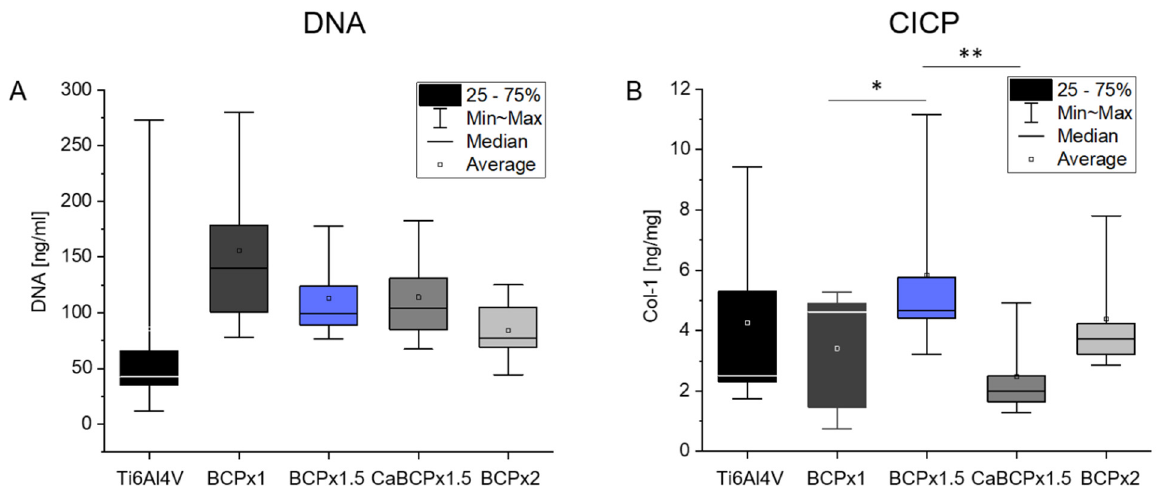
Figure 3. Analysis of biocompatibility from coatings precipitated on chemically pre-treated Ti6Al4V substrates after exposure to BCPx1, BCPx1.5 with and without CaCl2 pre-treatment, and BCPx2 for 14 days using human osteoblasts. ( n = 5). ( A ) DNA concentration in ng/mL of lysed cells. ( B ) Type I C-Terminal Collagen Propeptide (CICP) concentration in the cell supernatant normalized to the total protein content of the supernatant in ng/mg. * indicates significant differences between CaP coatings: * p < 0.05 and ** p < 0.01.